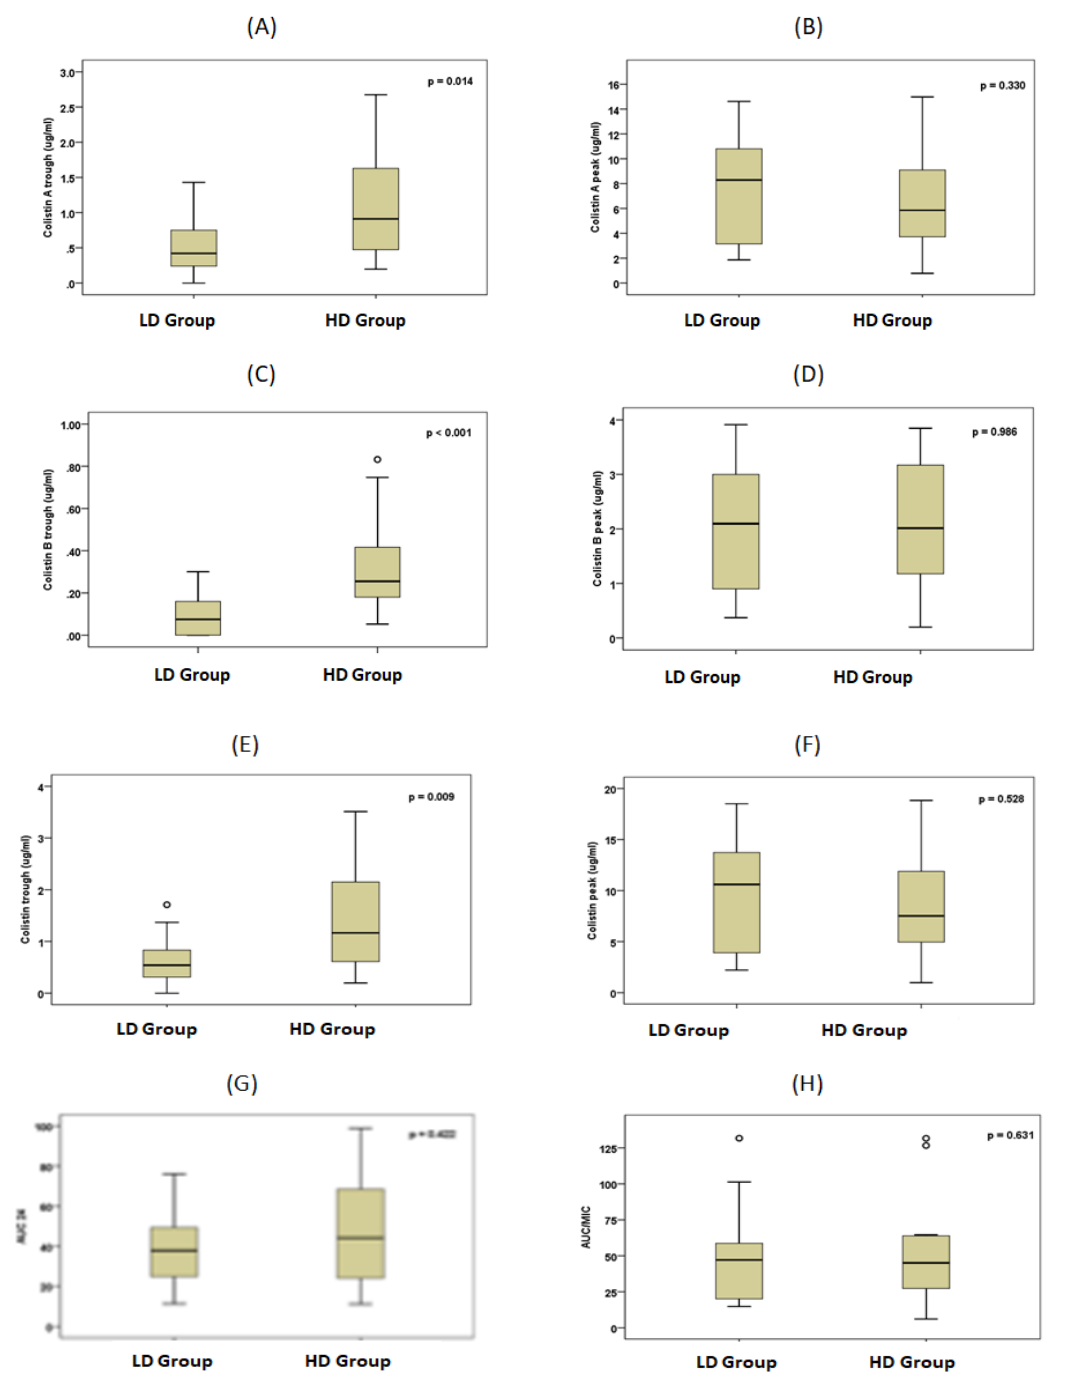
Fig. 1. Box plot presenting serum levels of trough and peak concentrations of colistin A, colistin B, and total colistin. A. Colistin trough A, B. Colistin A peak, C. Colistin B, D. Colistin B peak, E. total Colistin, F. total Colistin peak, G. AUC 24, H.